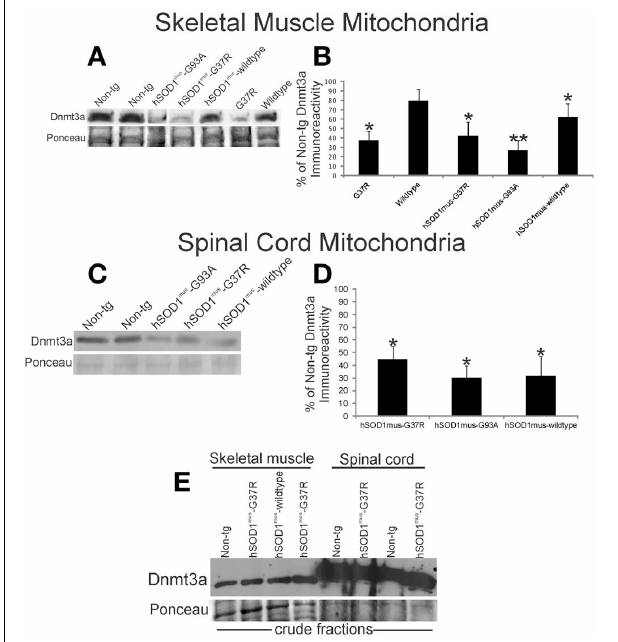
FIGURE 3 | Dnmt3a levels are reduced in hSOD1 tg mouse models of ALS. (A) Western blot for Dnmt3a in leg skeletal muscle mitochondria (100 µ g/lane) in non-conditional tg mice expressing hSOD1-G37R or hSOD1-wildtype constructs and conditional (muscle-restricted) tg mice expressing hSOD1 mus -G37R, -G93A, or -wildtype constructs compared to age-matched non-tg littermates. Ponceau S staining of membrane shows protein loading. (B) Graph showing the relative levels of Dnmt3a immunoreactivity determined by immunoblotting of pure mitochondria isolated from hSOD1 tg mouse leg skeletal muscle. Values are mean ± SD. Significant differences from non-tg control are indicated by single ( p < 0 . 05) or double ( p < 0 . 01) asterisks. (C) Western blot for Dnmt3a in spinal cord mitochondria fractions (50 µ g/lane) in conditional (muscle-restricted) tg mice expressing hSOD1 mus -G37R, -G93A, or -wildtype constructs compared to age-matched non-tg littermates. Ponceau S staining of membrane shows protein loading. (D) Graph showing the relative levels of Dnmt3a immunoreactivity in hSOD1 mus tg mouse spinal cord. Values are mean ± SD. Significant differences from non-tg control are indicated by an asterisk ( p < 0 . 05). The results have been replicated in at least 3 different experiments. (E) Western blot for Dnmt3a in crude fractions of skeletal muscle and spinal cord of conditional (muscle-restricted) tg mice expressing hSOD1 mus -G37R or -wildtype constructs compared to age-matched non-tg littermates. Ponceau S staining of membrane shows protein